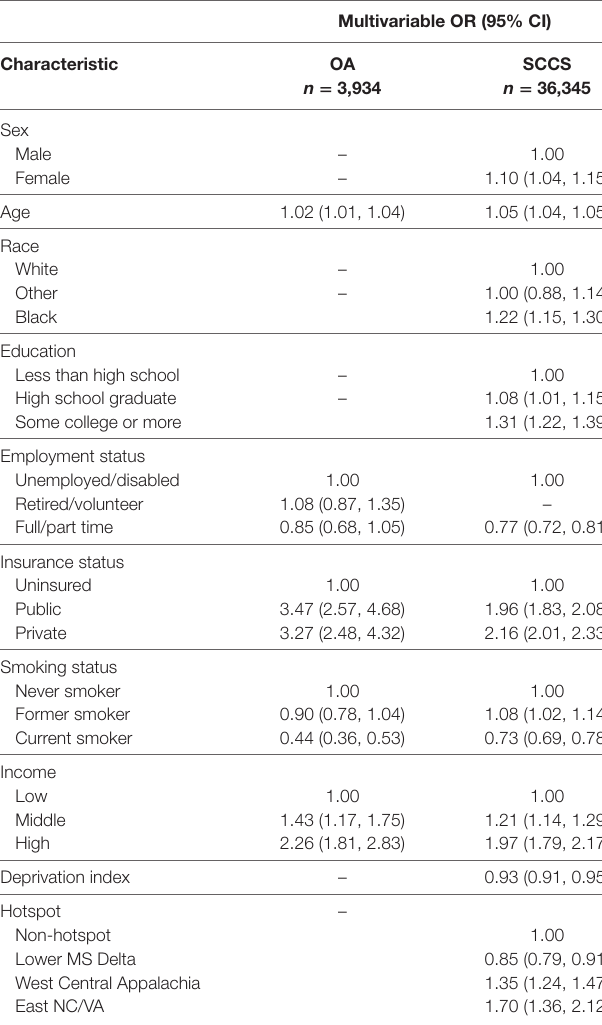
TaBle 2 | Multivariable logistic regression results for Ohio Appalachia (OA) and Southern Community Cohort Study (SCCS) participants’ receipt of colorectal cancer screening within